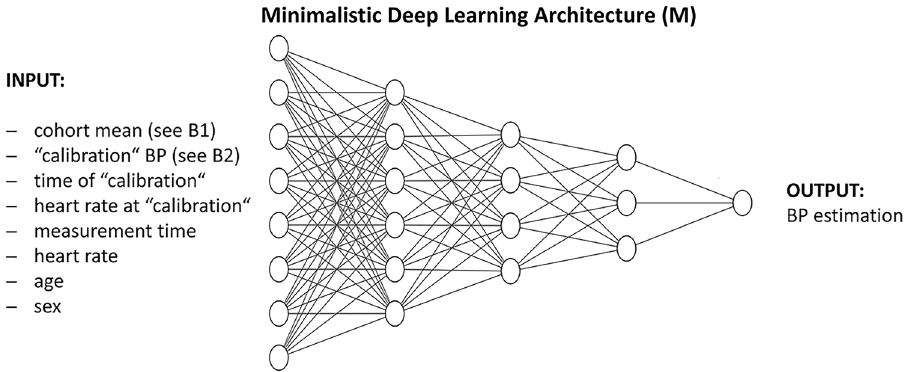
Figure 1. Minimalistic Deep Learning architecture used for M-RMSE calculation. It is a five-layer feed-forward Neural Network with Dropout and L2-Regression for ensuring reliable results. The system must be retrained for every dataset and provides BP estimations which are needed to M-RMSE calculation. For further information please see Supplementary Appendix